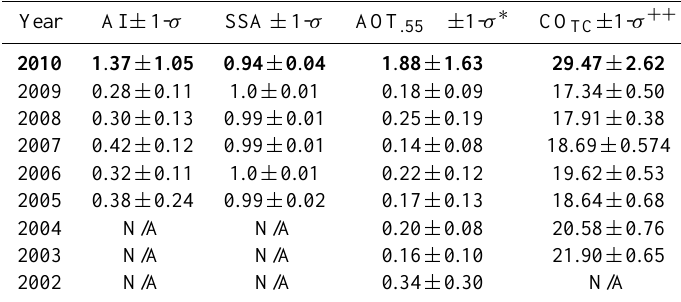
Fig. 6. Combined Aqua and Terra MODIS daily fire counts and FRP in (a) and (b) , respectively, accumulated within the domain of interest (purple box) shown in the map inset in (a) . The latitude and longitude range of this domain is 51 ◦ –57 ◦ N and 37 ◦ –49 ◦ E. The blue circles in the map indicate FRP > 200MW and the black star is the location of Moscow. 2010 fire counts and FRP are shown in orange.